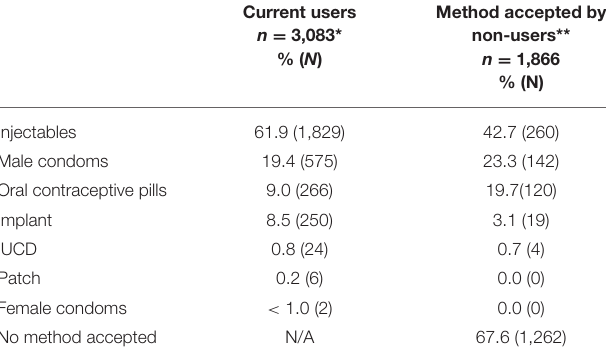
TABLE 2 | Contraceptive method type currently used at PrEP